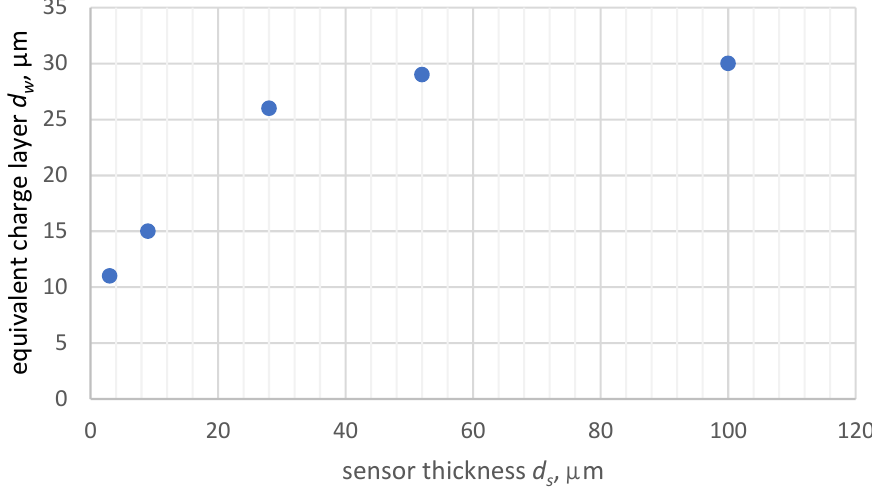
Figure 12. Impact of sensor thickness on the equivalent charge layer d w determined for different PVDF sensor thickness, pulser width t w = 5 ns, t r = 1 ns, LDPE sample.